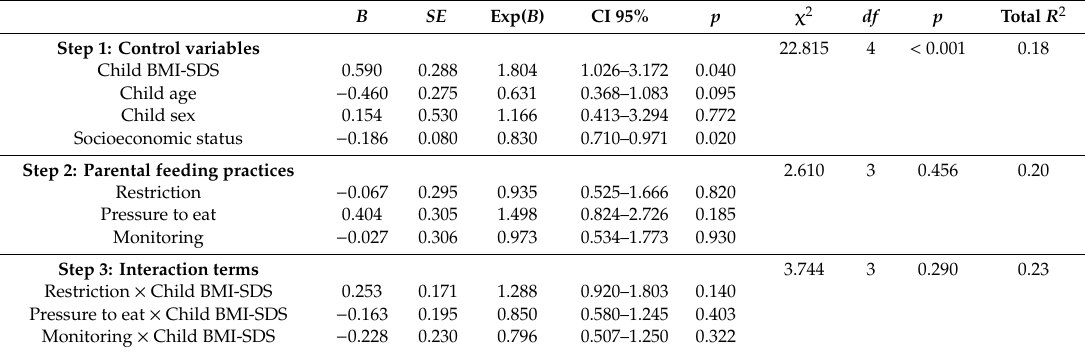
Table 3. Summary of hierarchical logistic regression analyses (full model) for the prediction of recurrent loss of control eating in children aged 8–10 years ( n = 366).